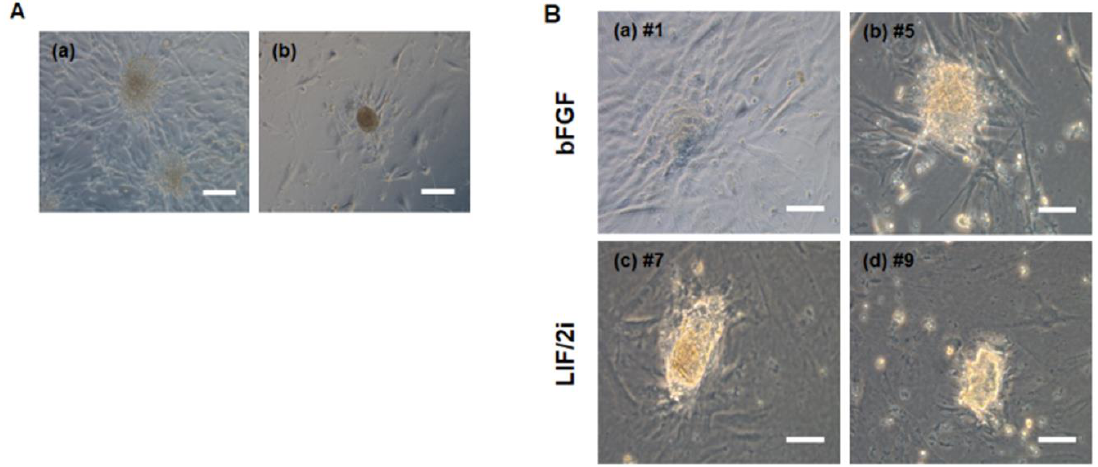
Figure 5. Morphological changes of canine induced pluripotent stem cell (ciPSC). ( A ) Representative images of radial colonies. (a) Radial colonies of putative ciPSCs were appeared at day 26 after VEE RNA transfection. (b) At passage 1, a flat and rounded colony appeared. Scale bars = 100 μm. ( B ) Morphological changes of ciPSCs culture in the presence of basic fibroblast growth factor (bFGF) or leukemia inhibitory factor (LIF)/ PD0325901 and CHIR99021 (two inhibitor; 2i). (a, b) The attached clumps appeared under bFGF-only conditions. (c, d) The culture conditions were changed to LIF/2i. Scale bars = 200 μm.